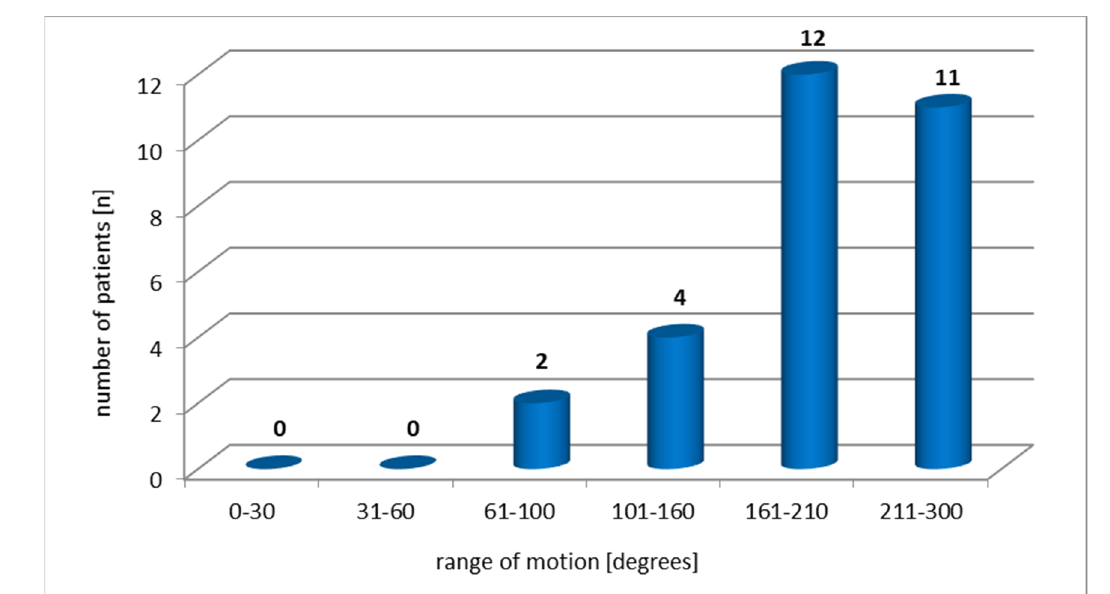
Figure 2. Hip range of motion according to HHS. Table 4. Functional state and the reduction of the